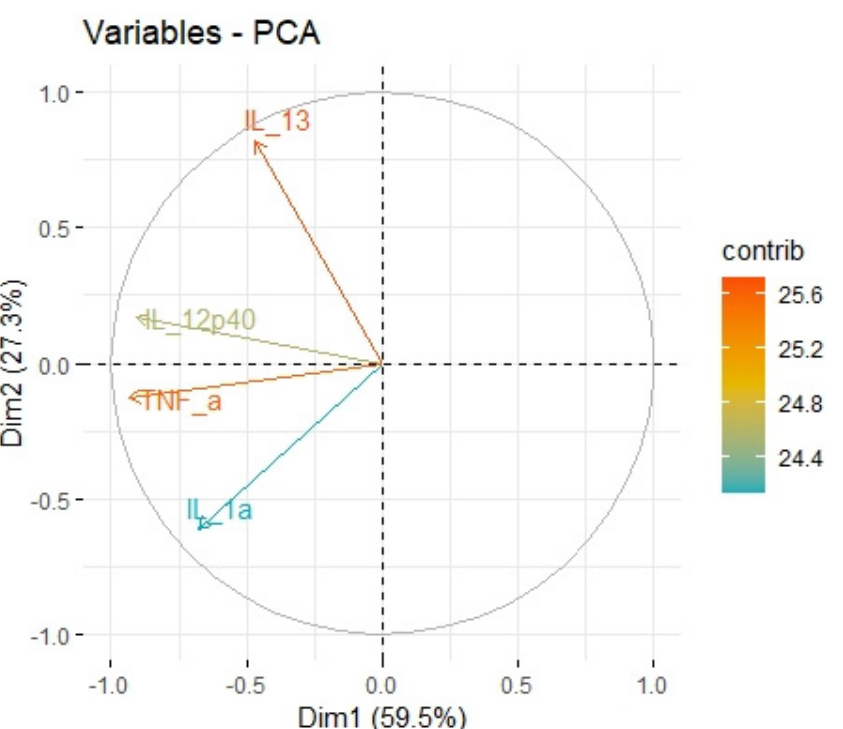
Figure 9. Principal components of antitumor cytokines representing variance in two dimensions. PCA loading plot showing PCA of the antitumor cytokines and correlation circle is demonstrated around the PCA. X-axis (Dim1/factor1) is orthogal to y-axis (Dim 2/factor 2). The color and length of vector indicate how strongly each cytokine contributes to principal components/factors (Dim 1 and Dim 2) and how original concentrations of cytokines are associated with their coordinate values.